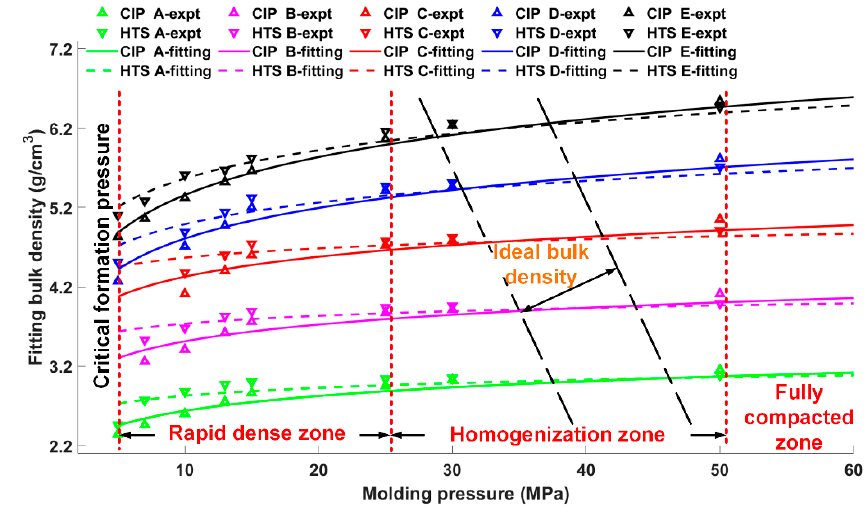
Figure 6. Relation between bulk densities and molding pressures of porous reactive materials.